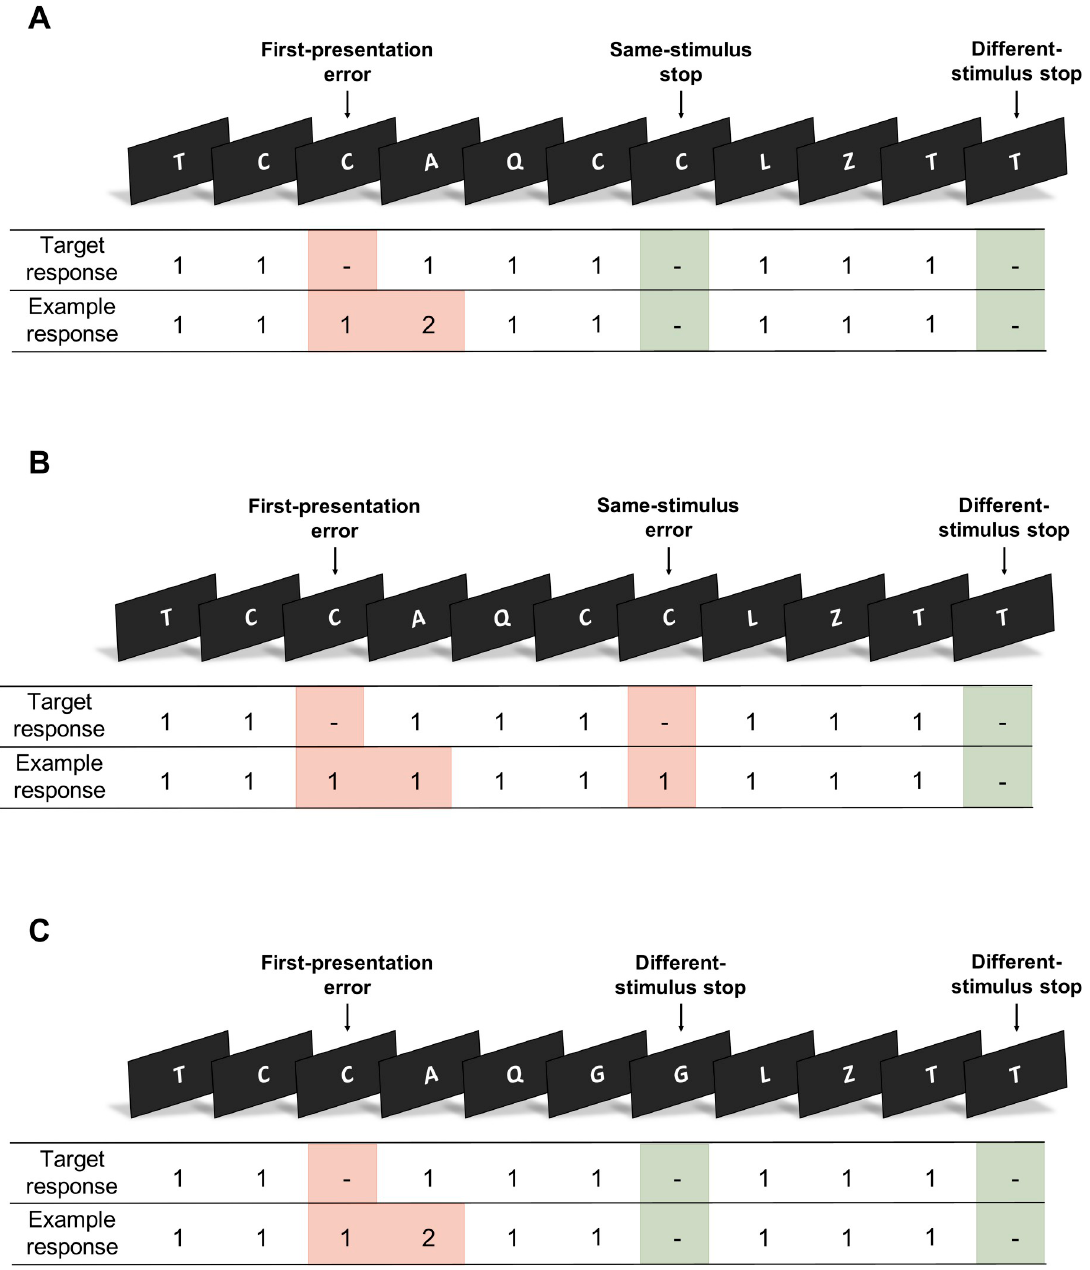
Fig 2. Classification of No-Go events. Participants responded to each letter using a left button press (‘1’) and withheld their response whenever a letter was presented consecutively (No-Go trial). To indicate error awareness, participants were required to forgo making a standard ‘Go’ response and to instead execute a right button press (‘2’) on the trial following the commission error. No-Go trials that presented the same stimulus as the previous No-Go trial were classified as ‘same-stimulus’ No-Go trials. Those that presented a different stimulus were classified as ‘different-stimulus’ No-Go trials. No-Go trials were categorised based on performance (errors shaded red, correct stops shaded green). For 75% of first-presentation No-Go errors, the next No-Go trial was a same-stimulus No-Go trial (A). For the remaining 25% of first-presentation No-Go errors, the next No-Go trial was a different-stimulus No-Go trial (C). The No-Go trial following a correct stop was always a different-stimulus No-Go trial (A, C).